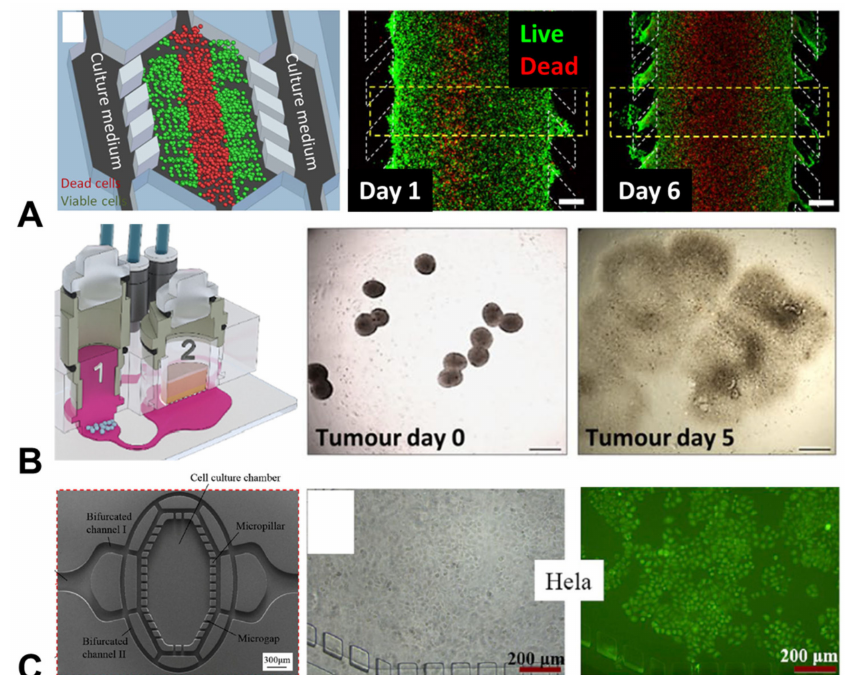
Figure 2. Organ-chip models of tumour growth and cancer cell proliferation. ( A ) Proliferation of cancer cells over 5 days in a chip model of human colon carcinoma (red = dead cells; green = live cells; scale bar = 400 µ m) [31]; ( B ) A chip co-culture used to investigate the growth of (1) lung tumours and (2) skin microtissues over 5 days (scale bar = 500 µ m) [32]; ( C ) A chip model exploring the proliferation of cervical cancer cells over 5 days, with staining delivered via tumour targetting nanoparticles [33]. Figures reproducued with